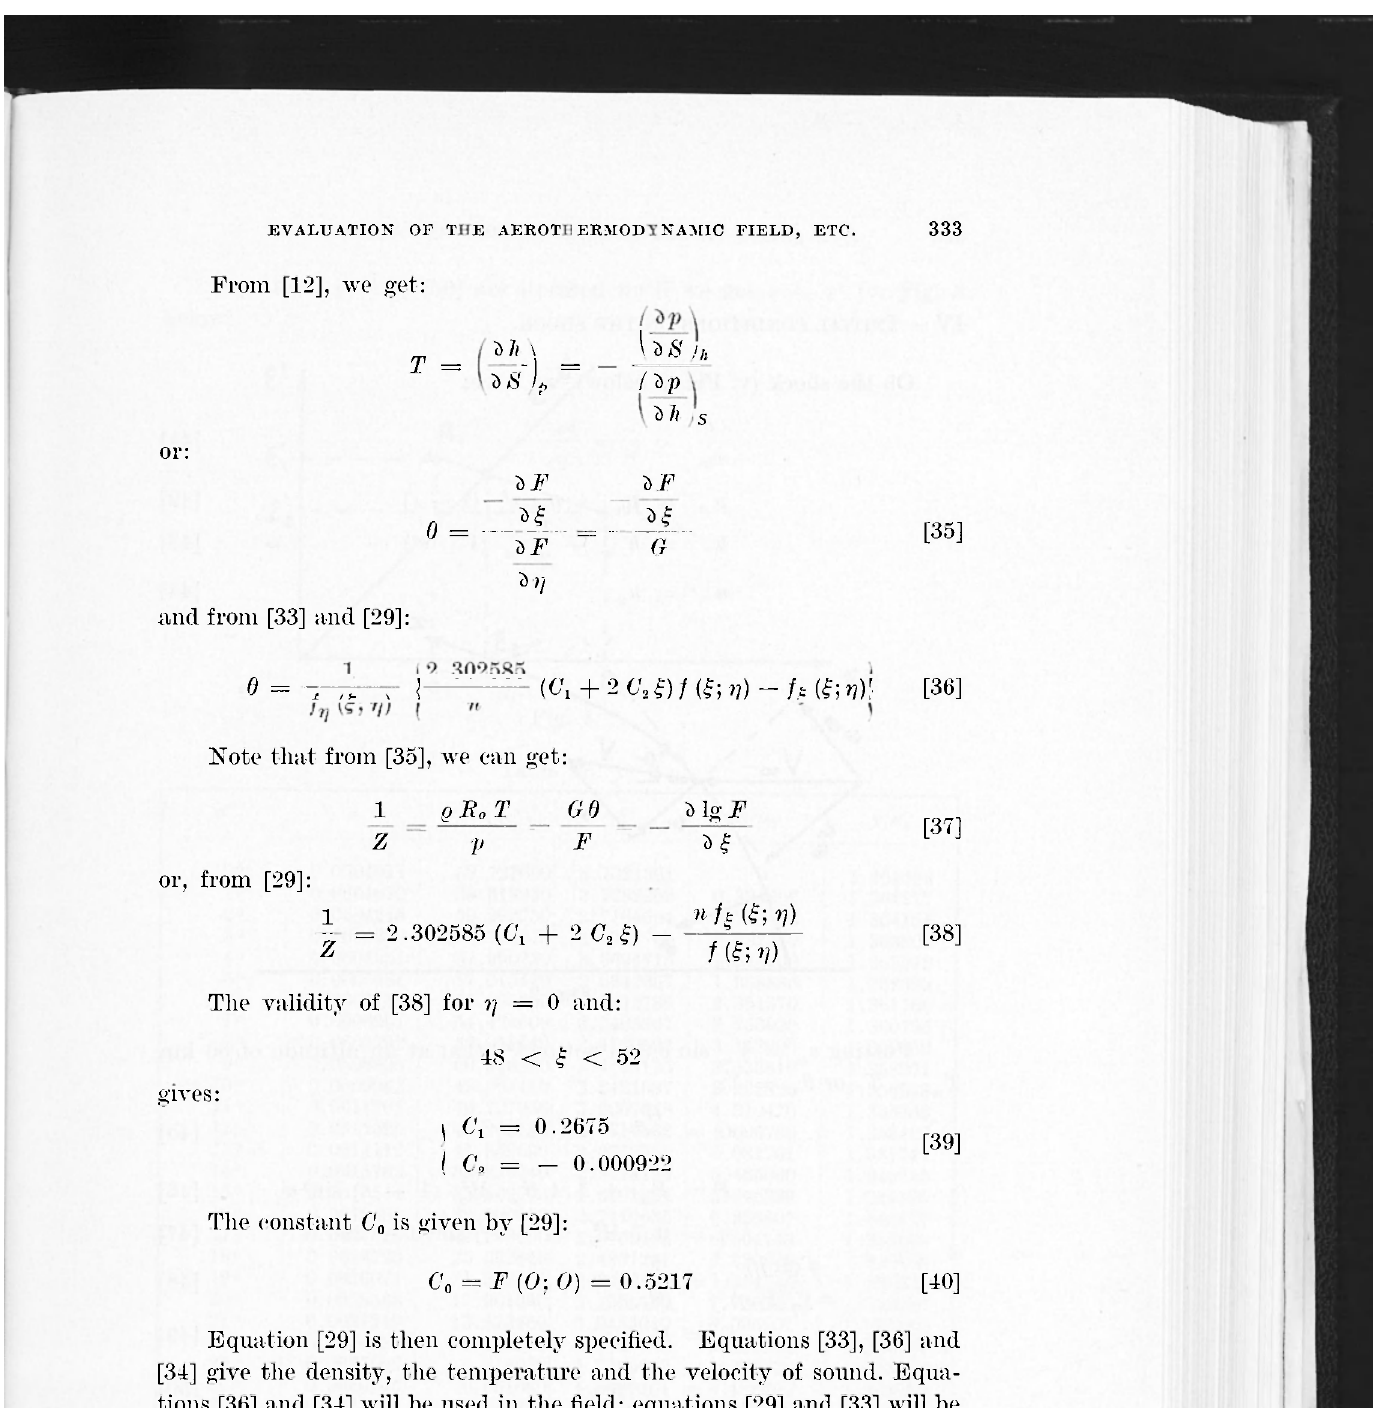
EVALUATION OF TUE AEROTIIERMOD YNAMIC FIELD,